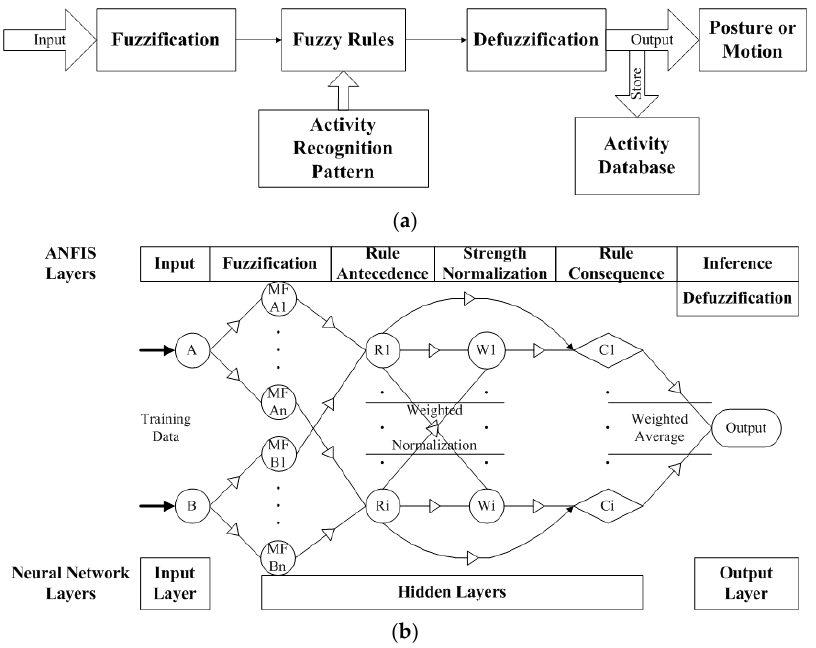
Figure 4. Fuzzy computing procedures for activity recognition: ( a ) the fuzzy inference process; ( b ) ANFIS modeling nodes based on fuzzy inference system and neural network layers.